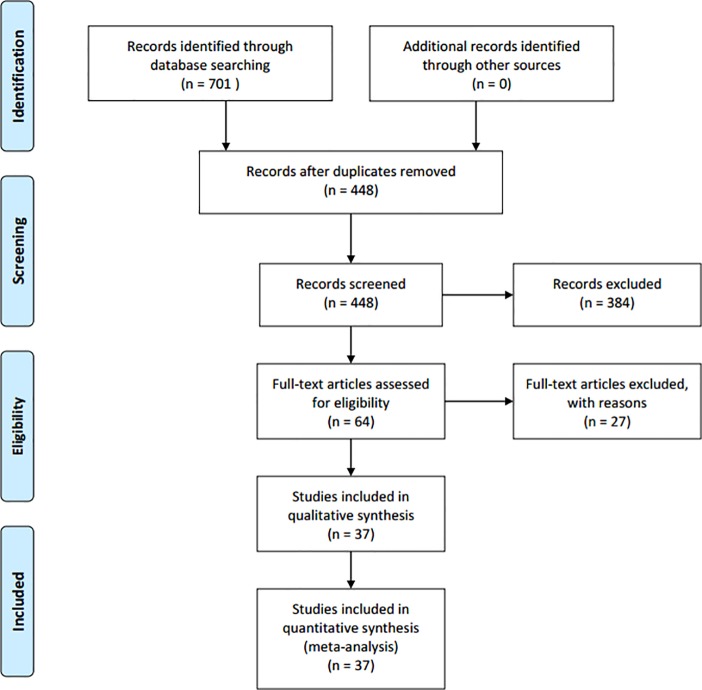
Process of literature search and selection.